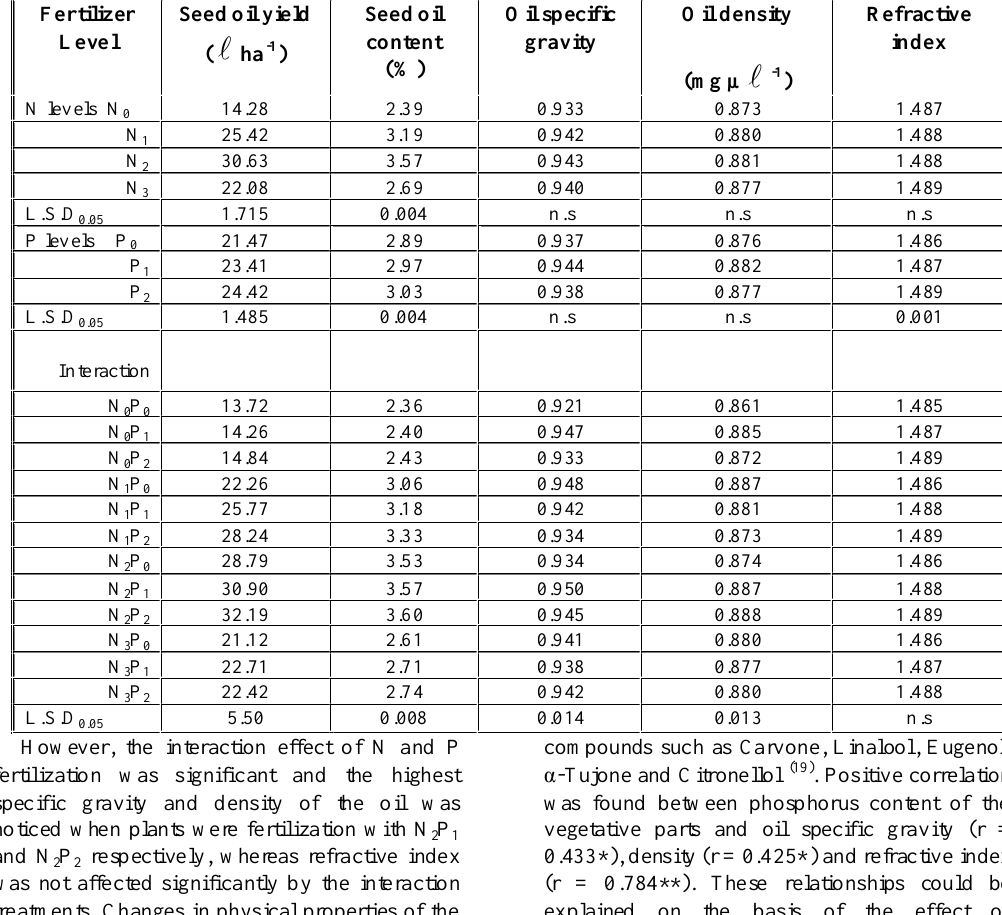
Table 1. Effect of nitrogen and phosphorus levels on dill seed oil yield, concentration and physical